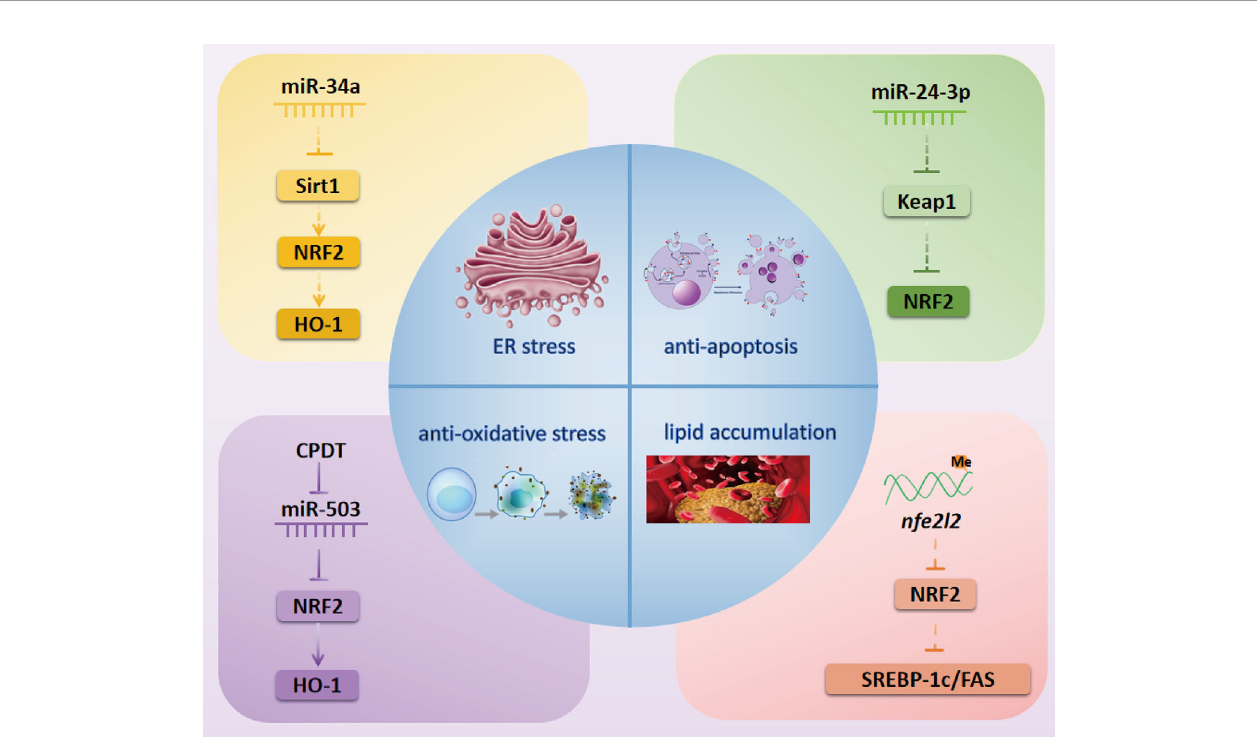
FIGURE 2 | NRF2-related possibly epigenetic mechanisms in diabetic cardiac complications. Inactivation of the Sirt1/NRF2/HO-1 pathway by miR-34a might cause ER stress in diabetic myocardial I/R injury. miR-24-3p might activate NRF2 by inhibiting the expression of Keap1 to exert an anti-apoptosis effect in diabetic myocardial I/R injury. CPDT can activate the NRF2/HO-1 pathway by inhibiting miR-503 to reduce oxidative stress in DCM. Methylation of the nfe212 promoter might inactivate NRF2 and its downstream targets SREBP-1c and FAS to cause lipid accumulation in DCM. NRF2, nuclear factor erythroid 2-related factor 2; miR, microRNA; Sirt1, Sirtuin1; HO-1, heme oxygenase-1; SREBP-1c, Sterol regulatory element-binding transcription factor 1c; FAS, fatty acid synthase; CPDT, 5,6- dihydrocyclopenta-1,2-dithiole-3-thione; Keap1, Kelch-like ECH-associated protein 1; ER, endoplasmic